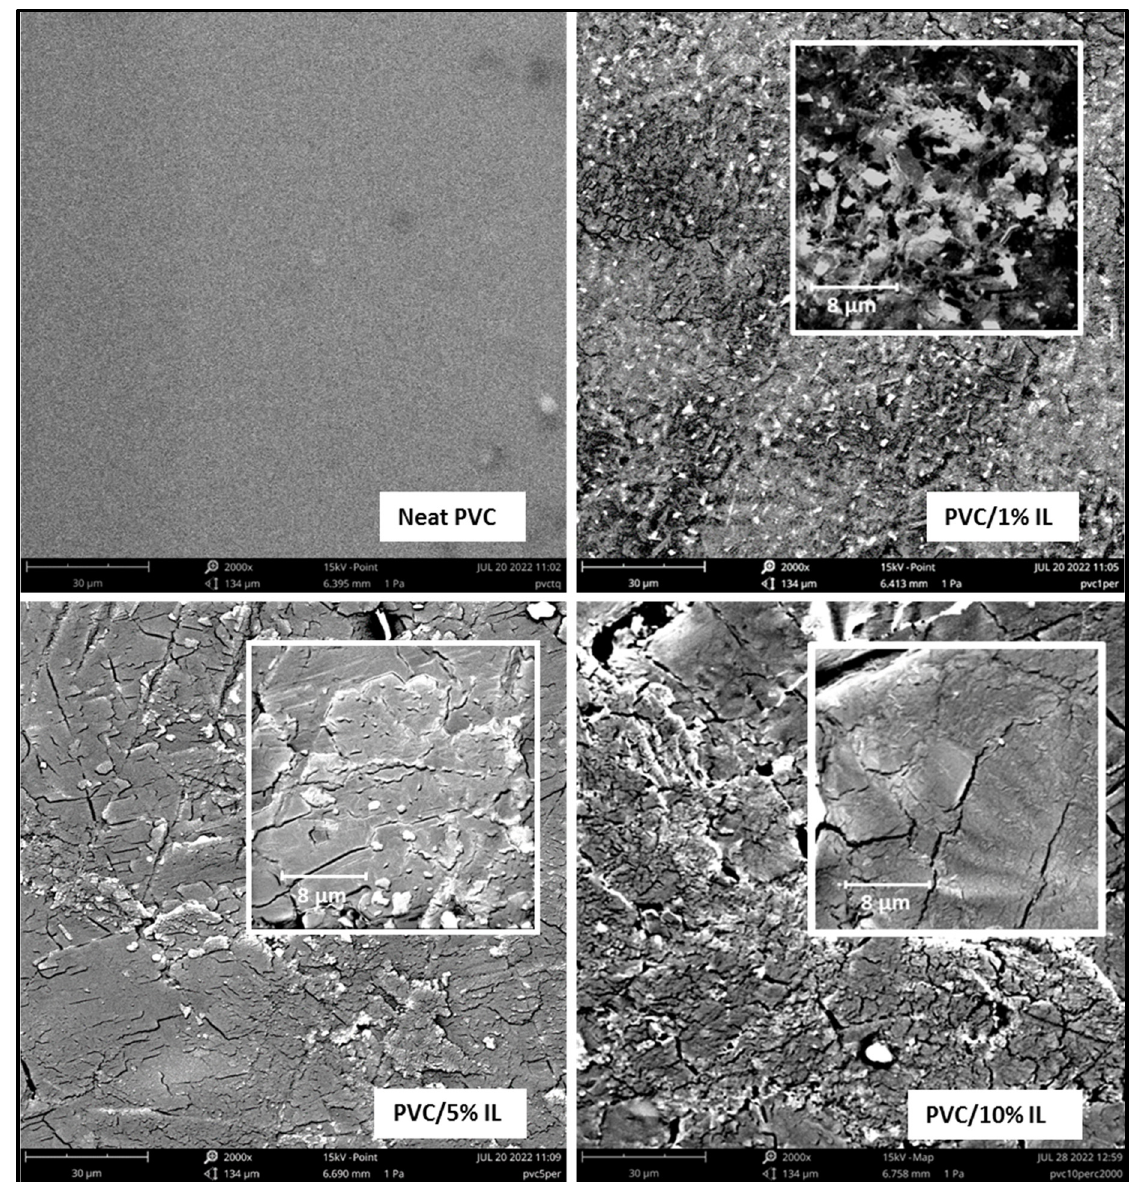
Figure 13. SEM images of neat PVC and PVC/HdmimDMSIP blends. Inset magnification 10,000 ×